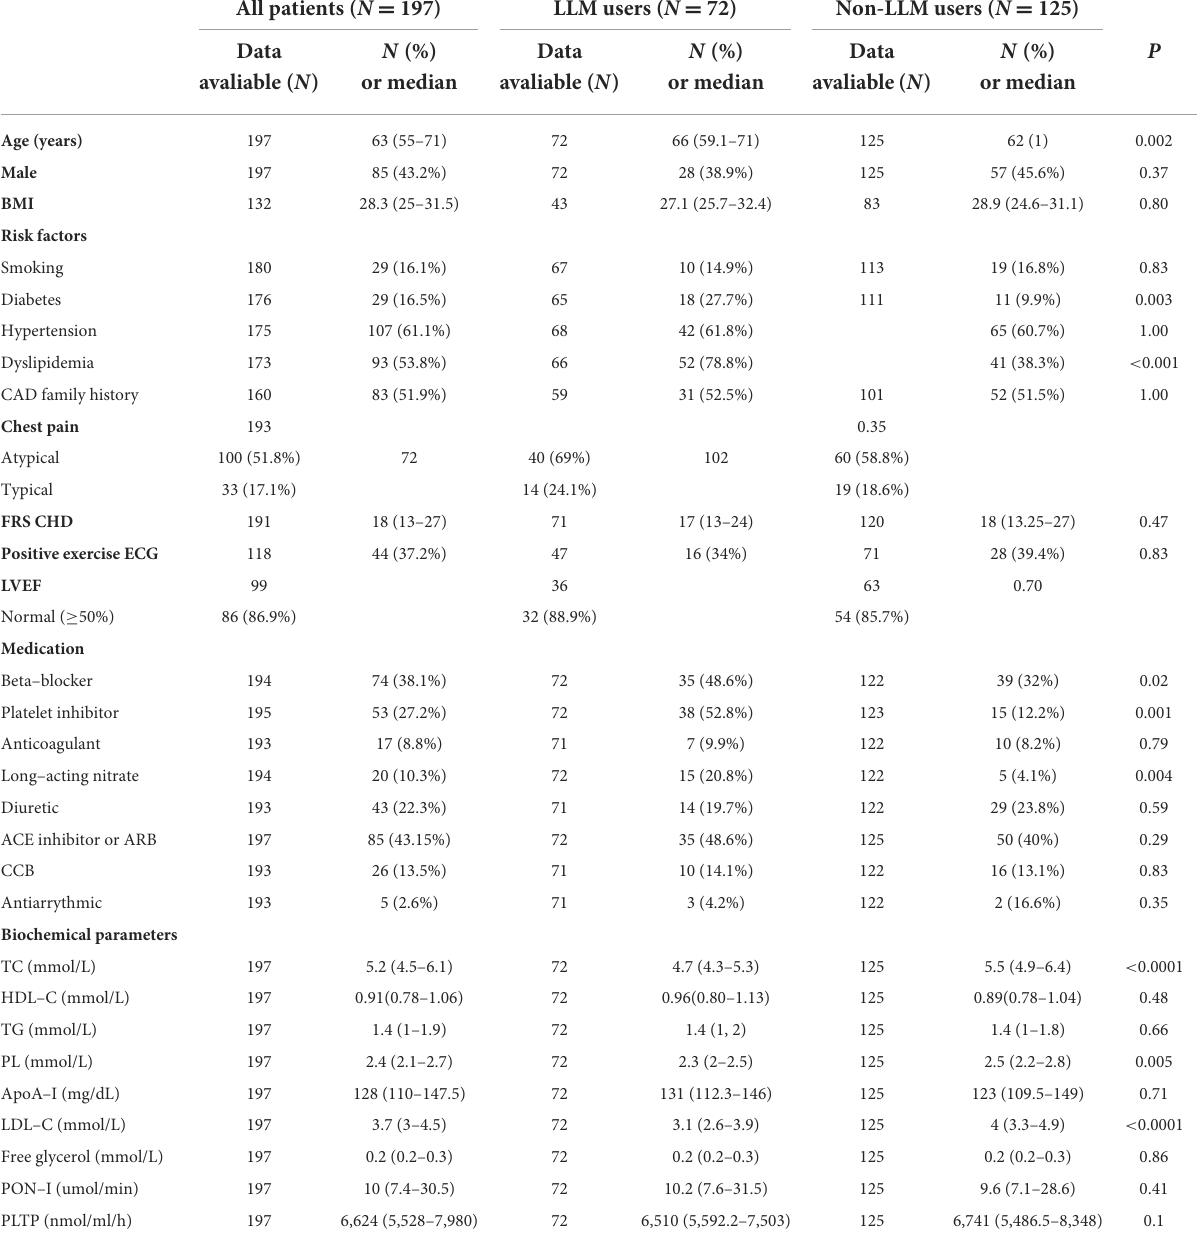
TABLE 1 Characteristics of the study